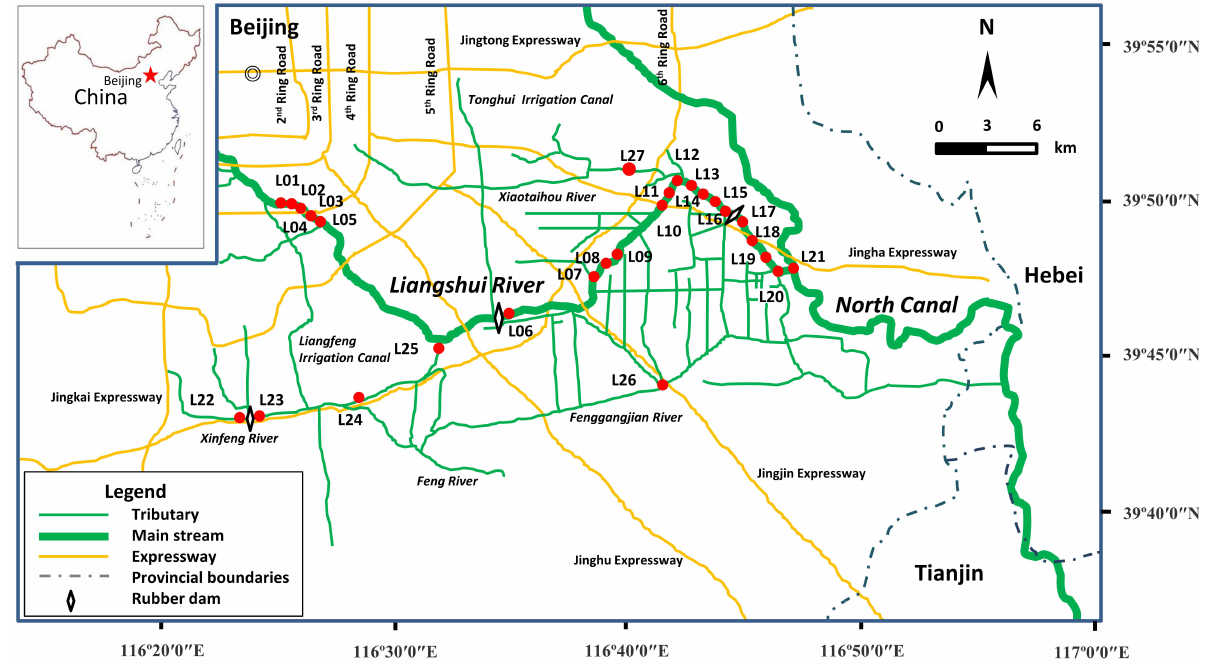
Figure 1. Sampling sites for the surface sediments from Liangshui River (LSR) in Beijing,